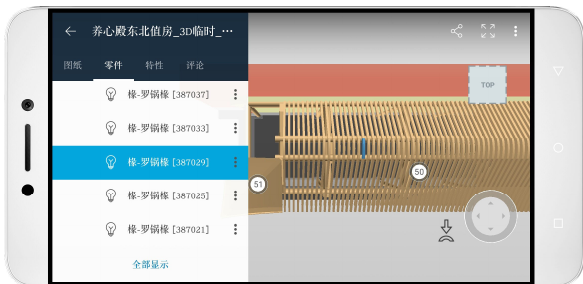
Figure 16 Accessing the interactive models and review it in a